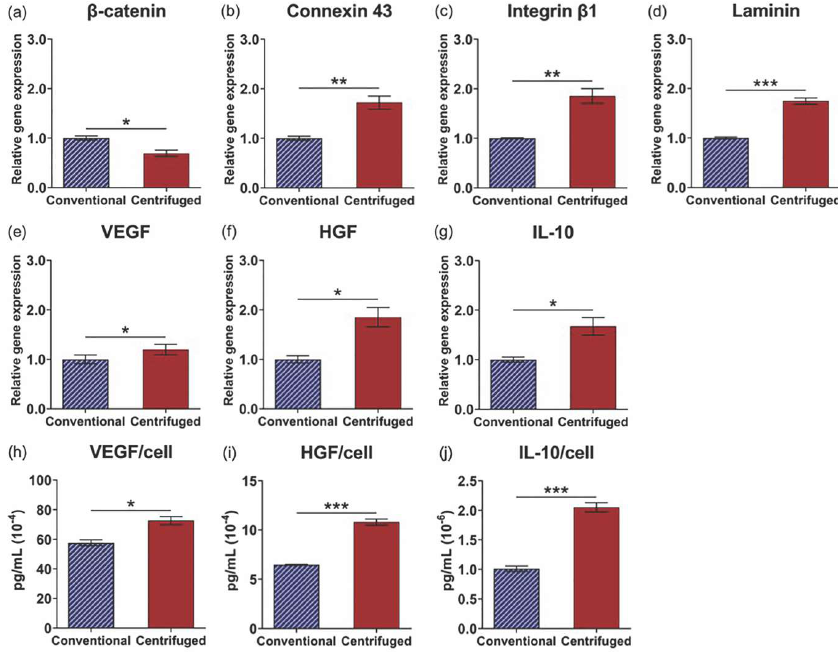
Figure 6. Centrifugation layering enhances MSC pro-regenerative cytokine production related to cellular interactions. Quantitative gene expression of cell interaction proteins ( a ) β -catenin, ( b ) connexin 43, ( c ) integrin β 1, and ( d ) laminin α 5 (ECM), and cytokines ( e ) VEGF, ( f ) HGF, and ( g ) IL-10 in 2-layer conventional and centrifuged cell sheets at 24 h. Analysis of cell sheet supernatants in static culture quantified ( h ) VEGF, ( i ) HGF, and ( j ) IL-10 secretion per 2-layer sheet over 24 h, normalized for average viable cell number. Gene expression is normalized to GAPDH and compared to the 2-layer conventional cell sheet. Values are means ± SE (* p < 0.05, ** p < 0.01, and *** p <